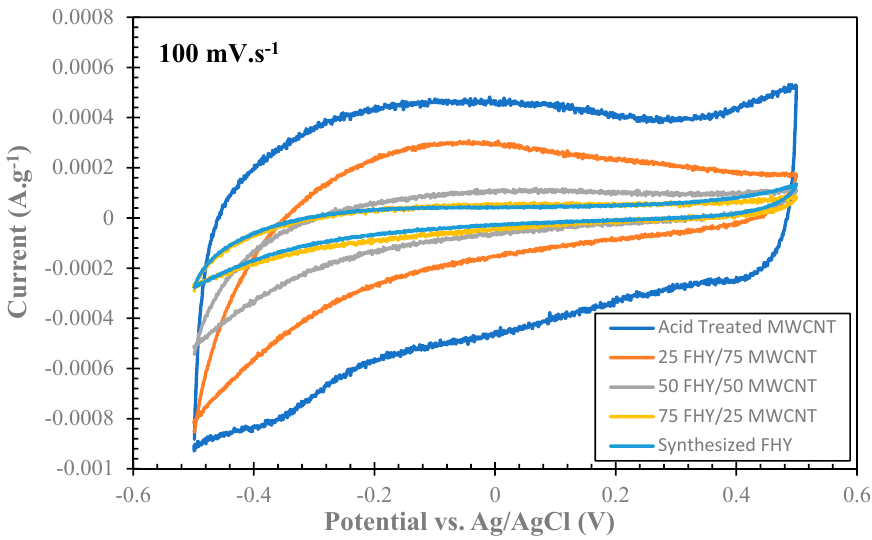
Figure 4. Cyclic voltammetry (CV) plot of all composite samples and controls at 100 mV·s − 1 in 0.5 mol·L − 1 Na 2 SO 4 electrolyte solution.